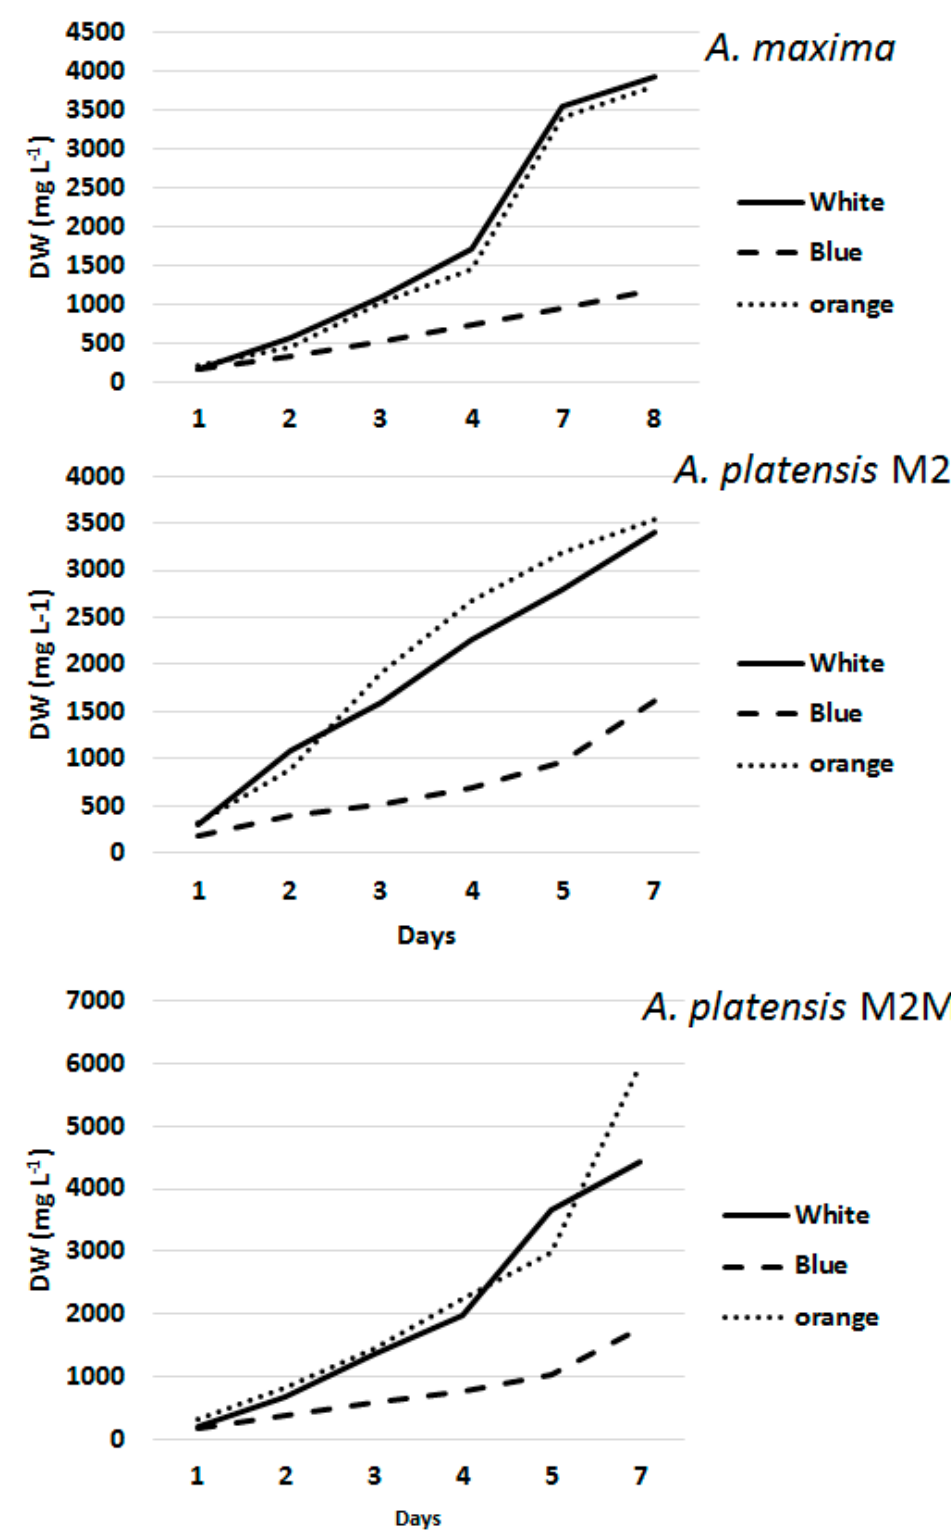
Figure 1. Dry weight (DW) increases after exposing the three selected strains to the irradiation lamps: white, orange and blue.